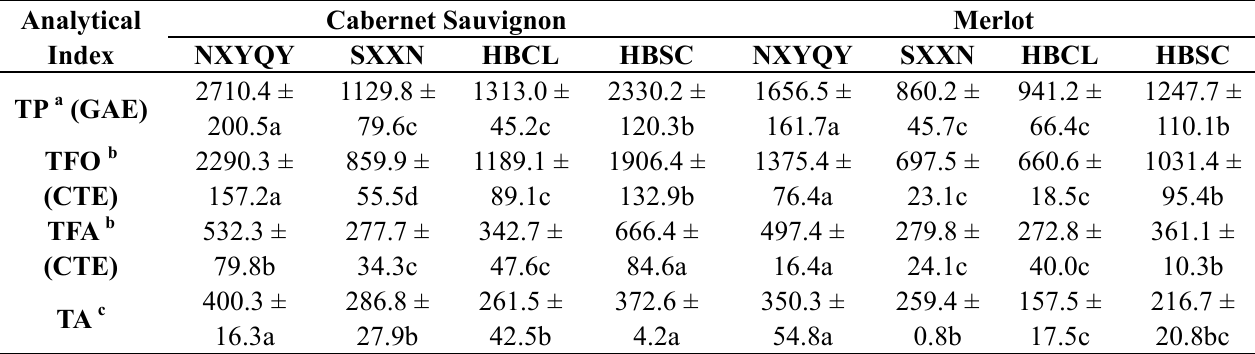
Table 1. Total amount of phenolic substances of Cabernet Sauvignon and Merlot wines from four different wine grape-growing